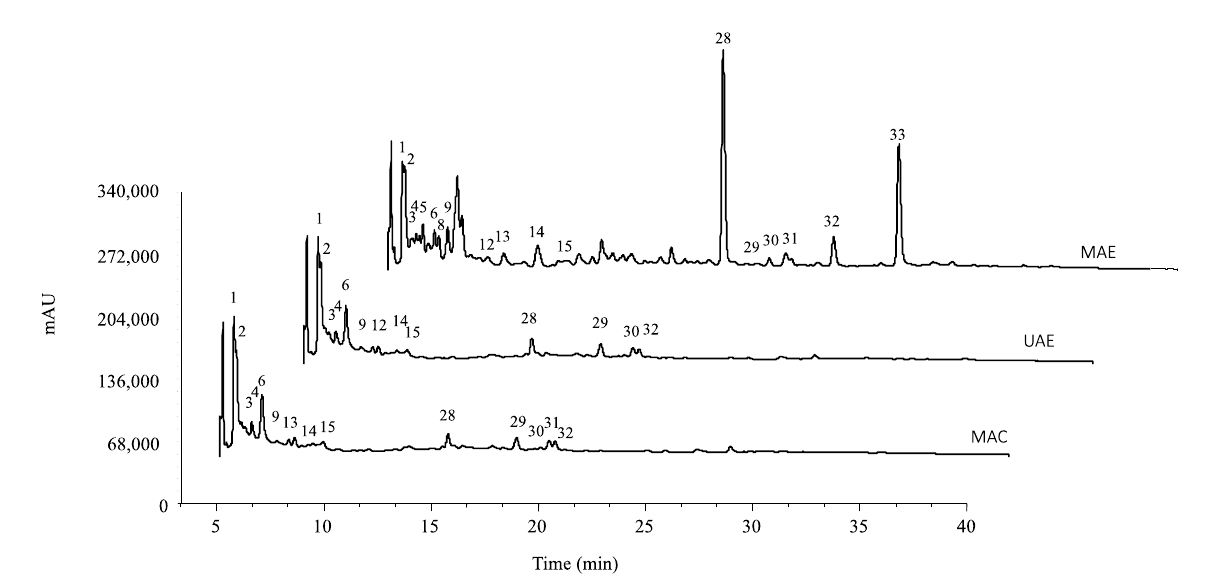
Figure 1. Phenolic profile of P. granatum hydroethanolic extracts recorded at 280 nm and their tentatively identified compounds. Peak numbers correspond to the compounds described in Table